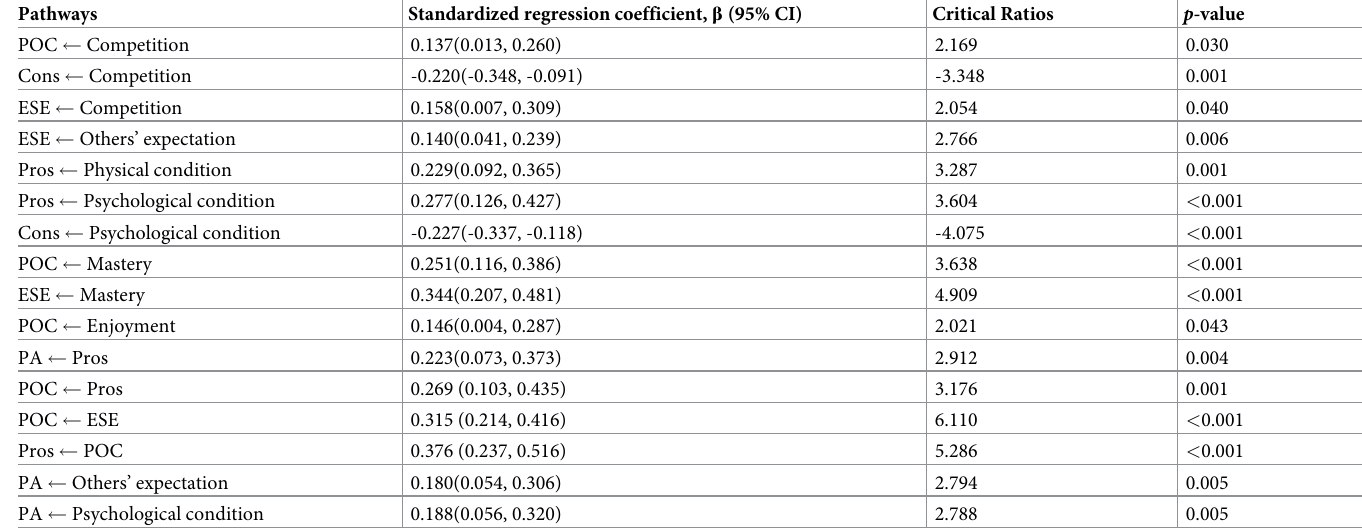
Table 3. Hypothesized path relationships in modified proposed